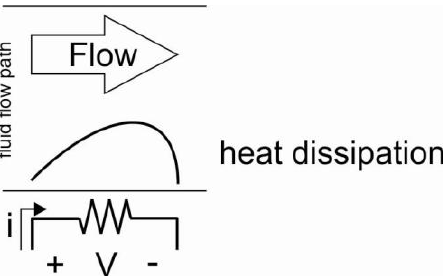
Figure 1. Illustration showing concept of hot wire anemometry. The resistor serves as a heater and sensing element. Resistance value is dependent on temperature.